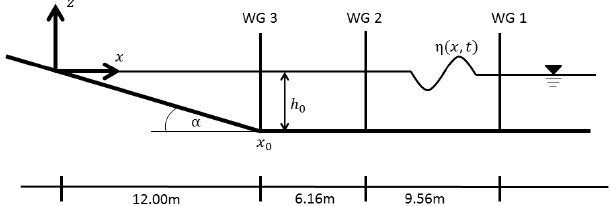
Figure 1. Schematic cross section of the considered setup: A constant depth region is attached to a linearly sloping beach with angle γ = tan α , where γ is the beach slope. Also indicated are the wave gauges (WG) from the experimental